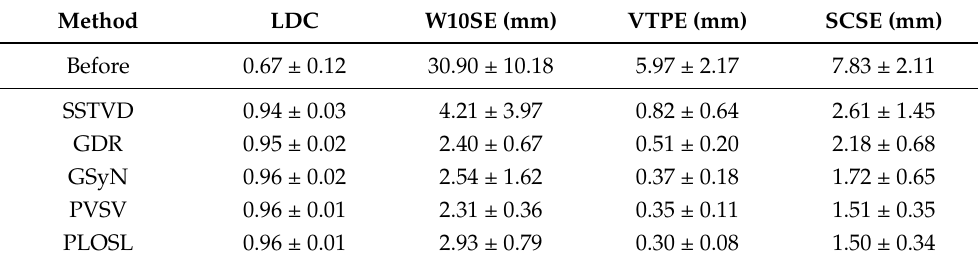
Figure 3. Violin plots of the TLC-to-RV registration performance using ( a ) Lung lobe Dice coefficient (LDC), ( b ) Worst 10% surface error (W10SE), ( c ) Vessel tree position error (VTPE), ( d ) Symmetric closest skeleton error (SCSE). The first column in each graph is the measure before registration. The five remaining columns correspond to values for the five algorithms: Sum-of-Squared-Tissue Volume-Difference (SSTVD), Geodesic Density Regression (GDR), Greedy Symmetric Normalization (GSyN), Pulmonary blood Vessel and lobe Surface Varifold (PVSV) and Population Learning followed by One Shot Learning (PLOSL), respectively. Note that a larger LDC value is better whereas a smaller value is better for the other three evaluation methods. Table 1. Comparison of registration performance of inspiration–expiration CT registration between four iterative-registration algorithms and a deep-learning-based registration method. Results are provided in mean ± standard deviation